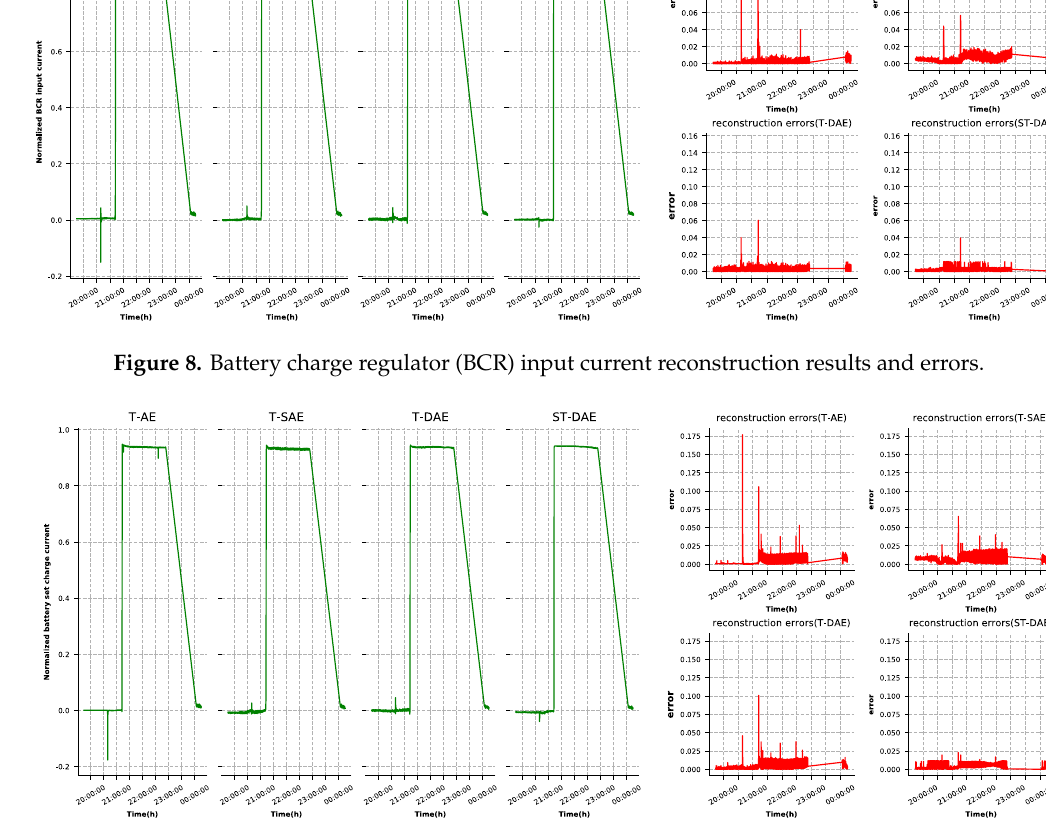
Figure 9. Battery set charge current reconstruction results and errors.